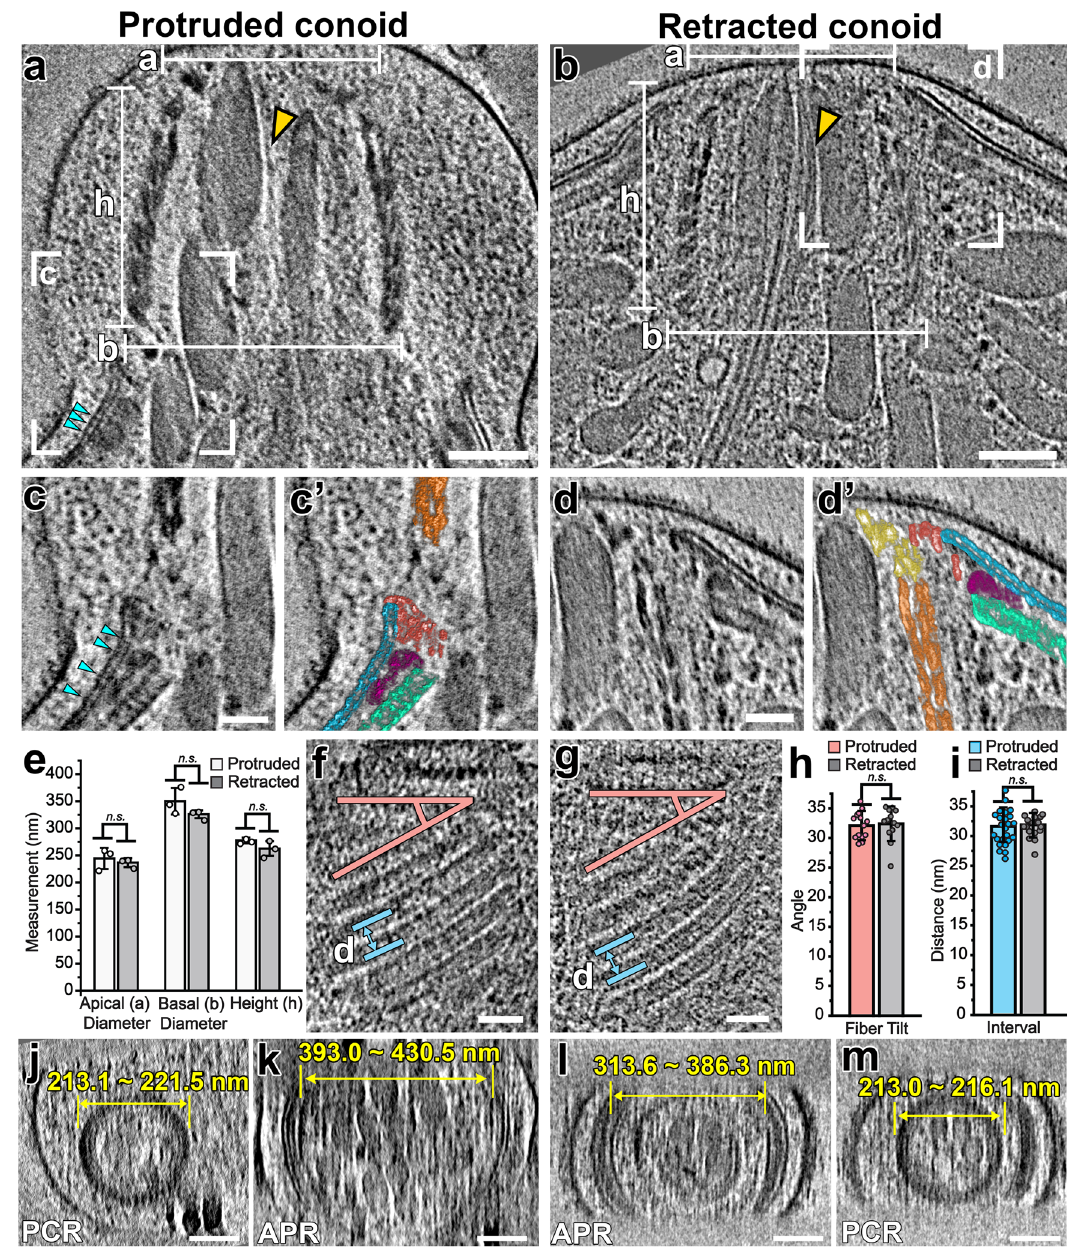
Fig. 3 | The overall structure of the conoid remains unchanged during the cycles ofprotrusion and retraction. a – d ’ Tomographic slices through the center oftheapicalcomplexshowtheconoidintheprotruded( a )andretracted( b )states. White lines indicate the measurements of the apical diameter ( a ), the basal dia- meter ( b ),and the height ( h ) of the conoid structure. White boxes in( a , b ) indicate the areas magni fi ed in ( c , d ) where the conoid and the APR-associated complex interact;( c ’ and d ’ )arethepseudo-coloredversionsof( c and d ),coloredasdetailed in Fig. 1. Note the elongated, sheet-like density (gold arrowheads in a and b ) tracking between micronemes and ICMT inside the conoid. IMC “ spacer ” densities areindicatedwithcyanarrowheadsin( a , c ). e Measurementsoftheapicaldiameter, the basaldiameter, and the height of protruded ( n =3 tomograms, white bars) and retracted( n =3tomograms,graybars)conoidsshownosigni fi cantchangesduring the cycles of protrusion and retraction. f – i Tomographic slices ( f , g ) through the edge of reconstructed conoids (showing the conoid fi bers in the longitudinal